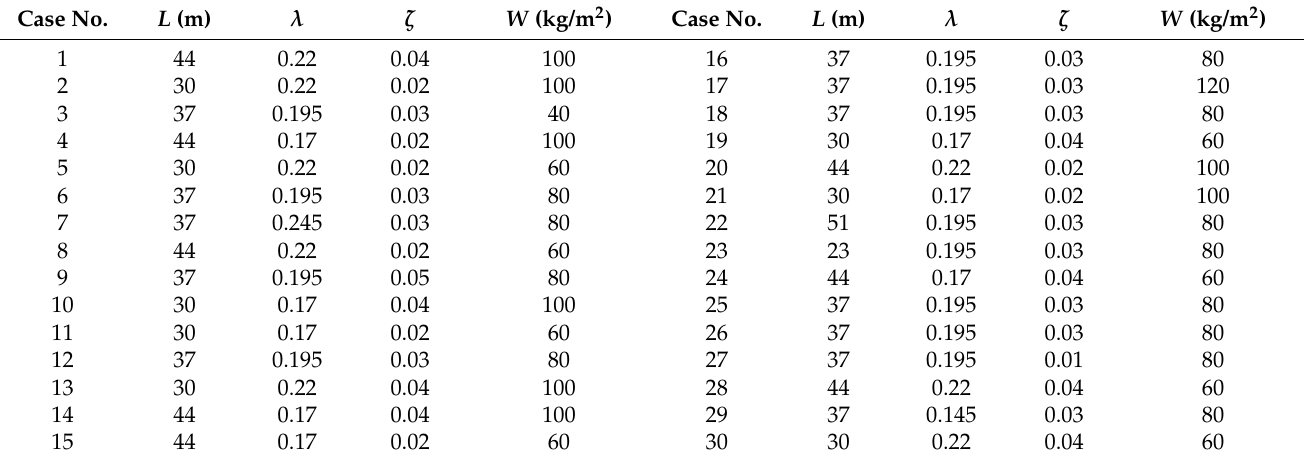
Table 3. Orthogonal calculation cases.